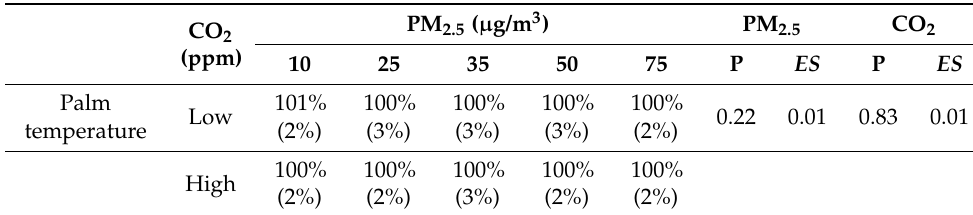
Table 7. Standardized results of palm temperature; effect sizes ( ES ) of 0.01, 0.06, and 0.14 indicate small, moderate, and large